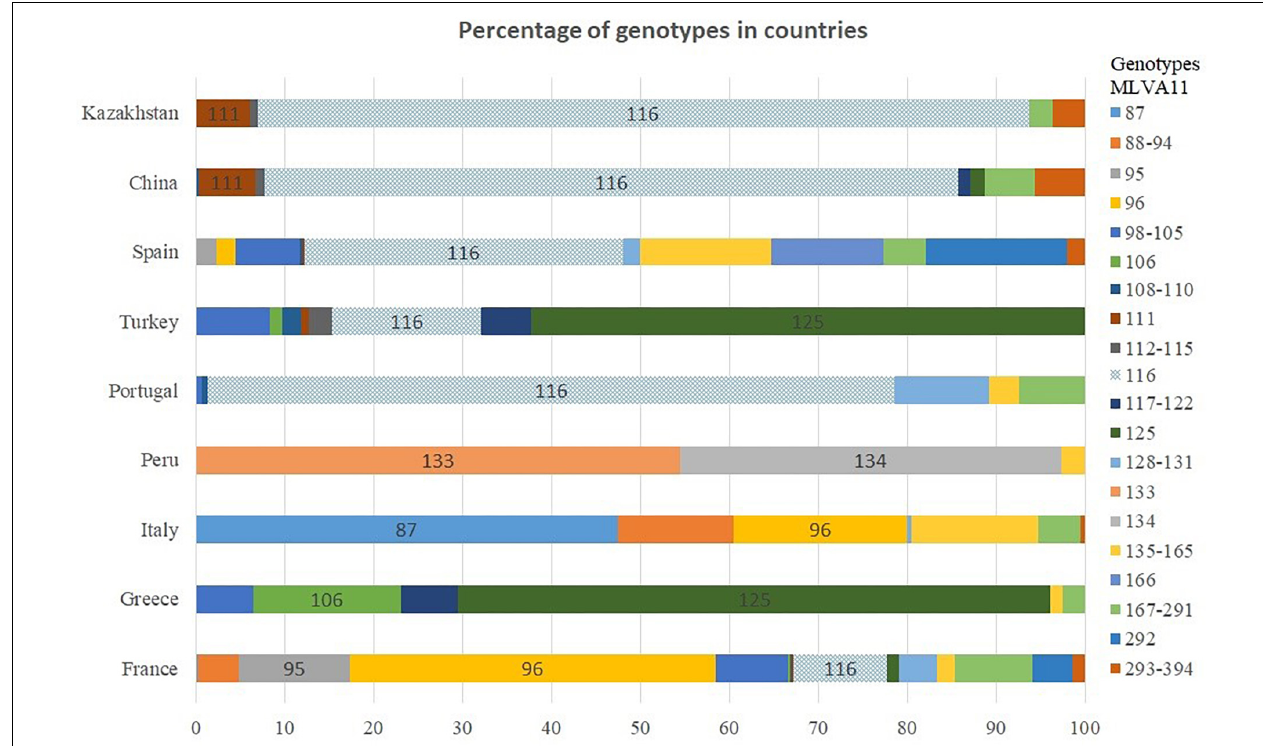
FIGURE 3 | Distribution of B. melitensis MLVA11 genotypes by